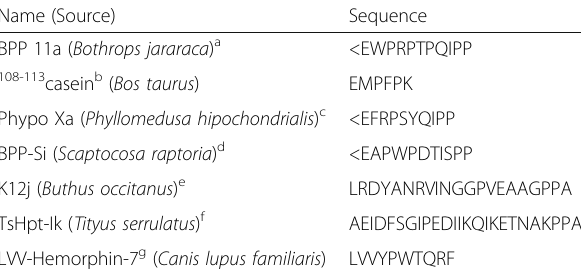
Table 1 Peptides displaying BPP activity isolated from different biological